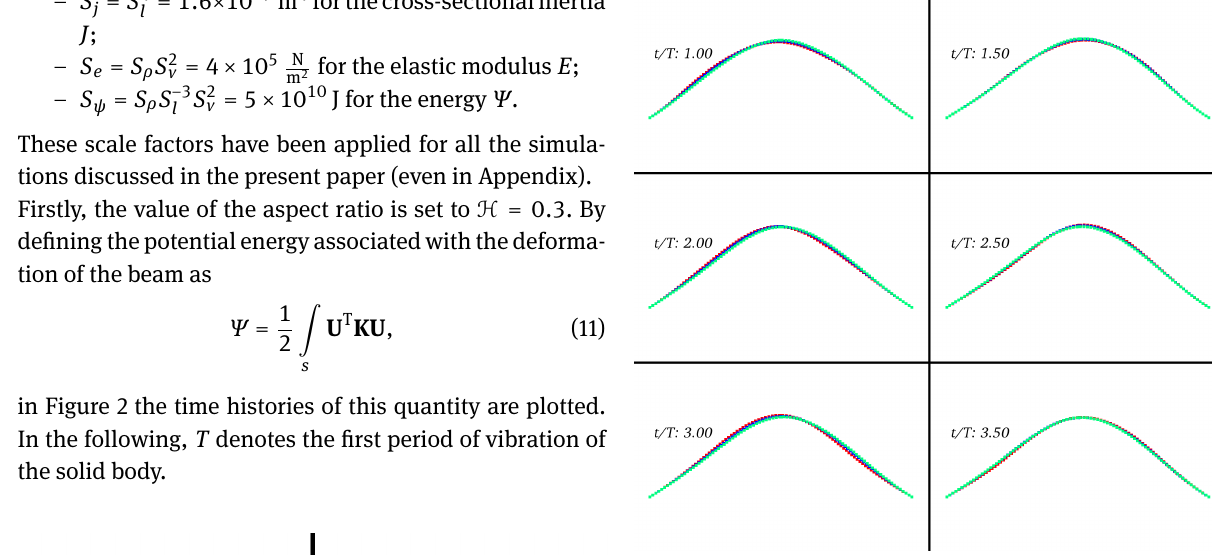
Figure 5: E = 40 . Configuration assumed by the solid body at differ- ent time instants at R = 15 (green curve), R = 50 (blue curve) and R = 100 (red curve).